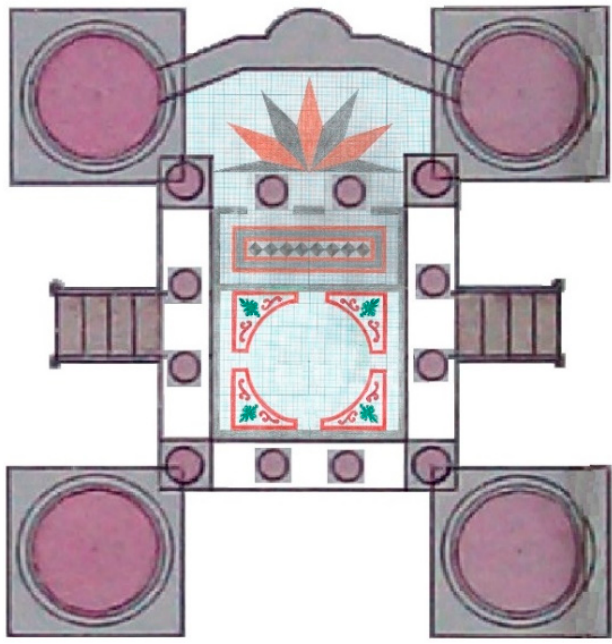
Figure 8. Floor illustration of the bimah —Composite: Shuli Levinboim and Jon Seligman, Israel Antiquities